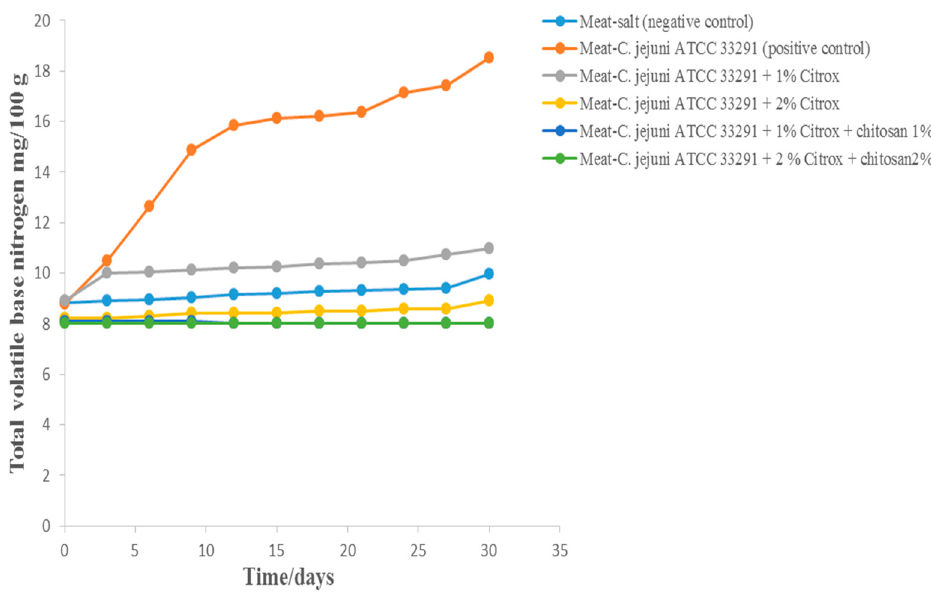
Figure 7. Total volatile base nitrogen ( TVB-N ) of camel meat samples during storage at 10 °C for 30 days.